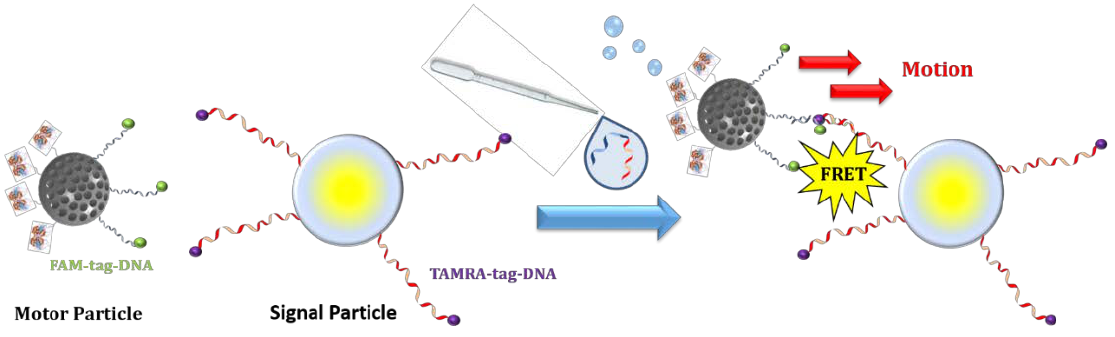
Figure 3. DNA motion-based assay based on Janus mesoporous silica nanoparticles.